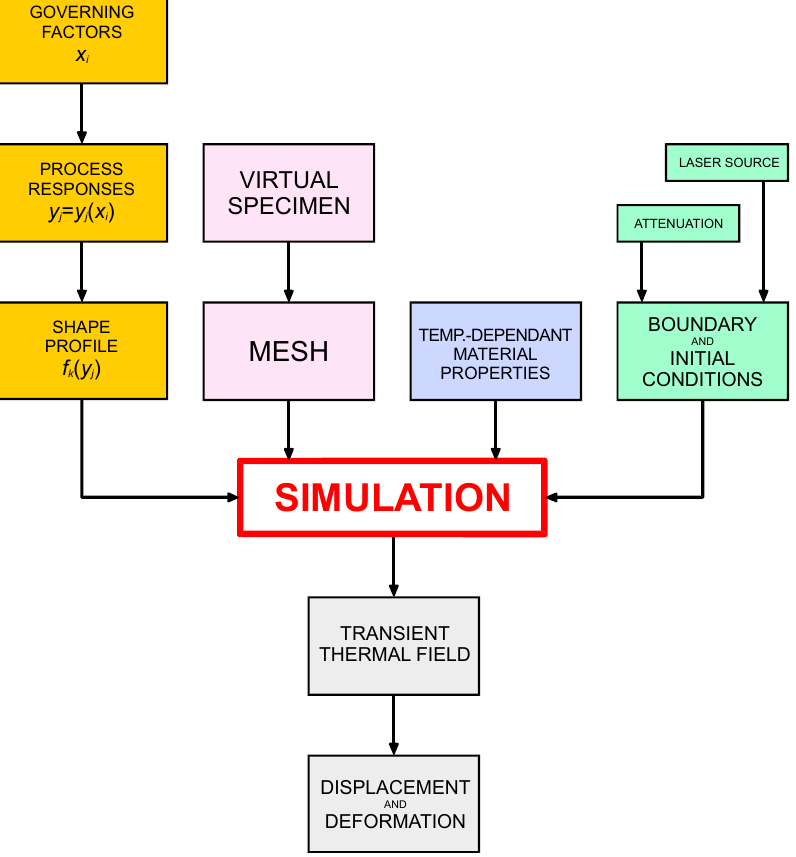
Figure 1. Logical flowchart of the global input to feed the simulation tool and compute the output.